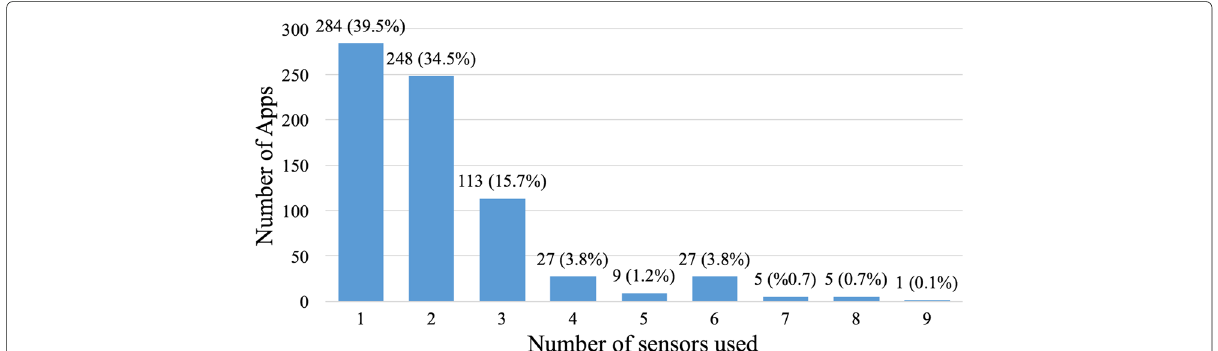
Fig. 7 Number of apps using different number of sensors; 284 (39.5%) apps use only one sensor and 248 (34.5%) use two sensors, which are the majority (74%) of the apps in the evaluation set